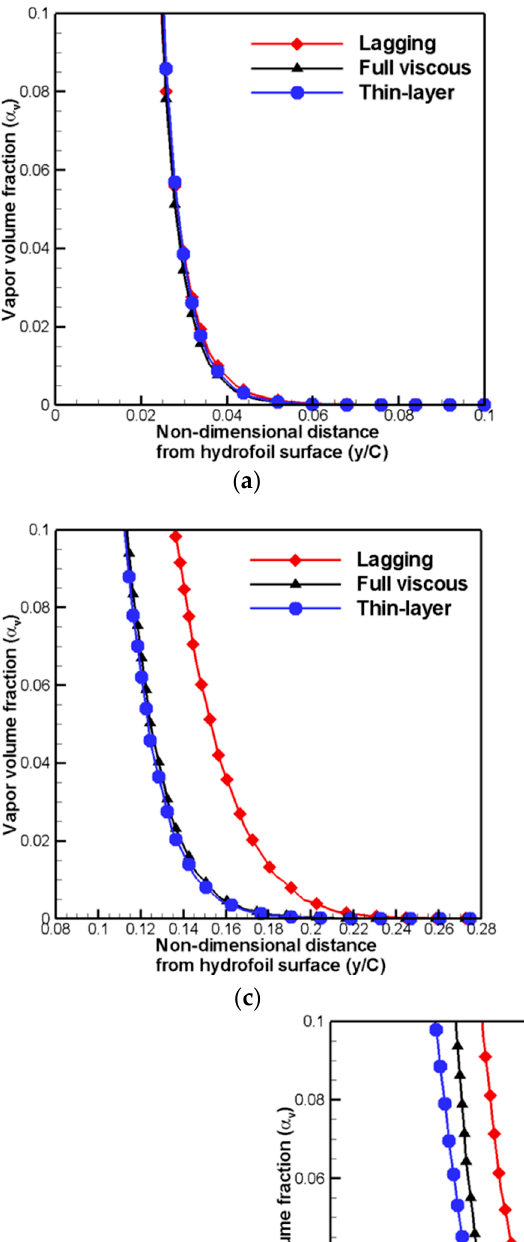
Figure 10. Time-averaged vapor volume fraction distribution at five stream-wise locations: ( a ) viscous lagging; ( b ) full viscous; and ( c ) thin-layer cases.